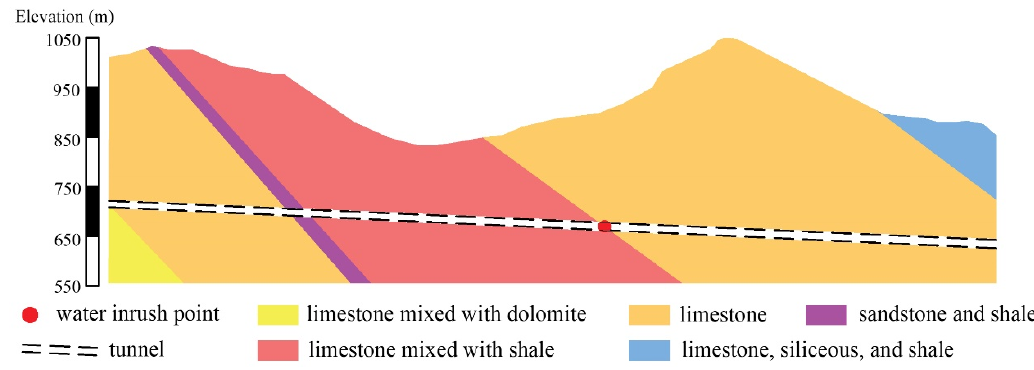
Figure 6. Sectional view of geological profiles for incident point.